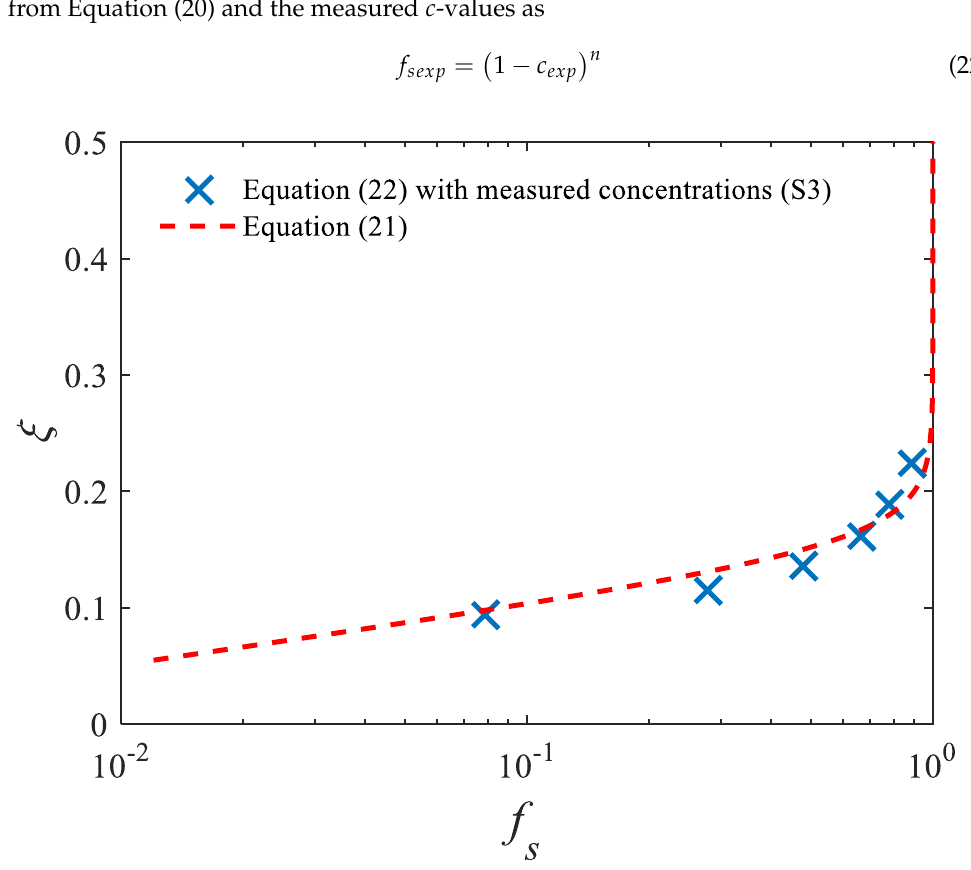
Figure 3. Vertical distribution of dimensionless settling velocity of sediments f s (y) = ω s (y)/ω s0 . Curve, Eq. (21); symbols, experimental data from Eq. (22) and measured concentrations (S3).